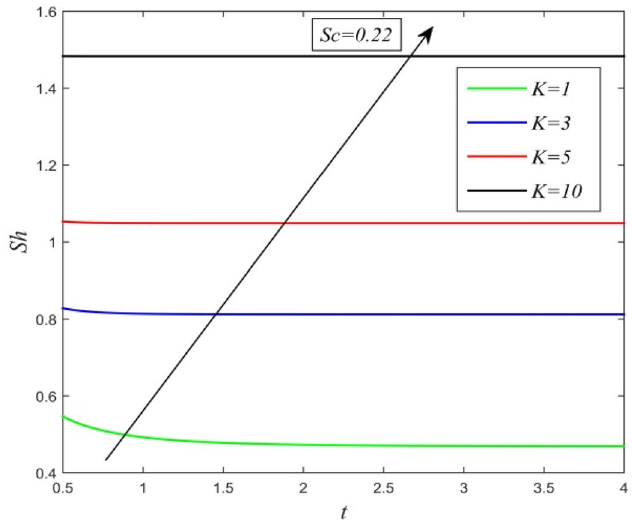
Figure 21. Sh versus t for different K and Sc = 0.22.